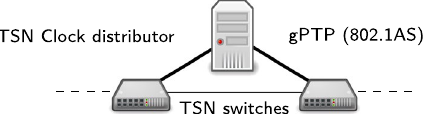
Fig. 1 A simple example of TSN network using the specialized PTP protocol (IEEE 1588), with a specialized profile called gPTP (802.1AS)